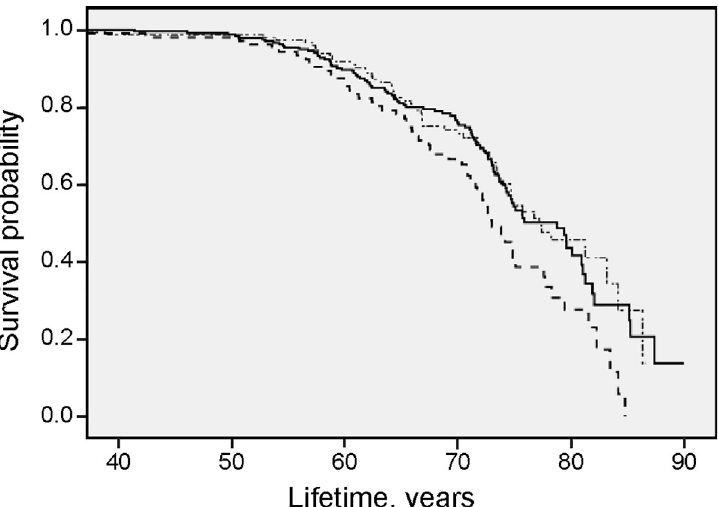
Fig 3. High all-cause mortality with a low serum phosphate level in smokers. Survival probability for all-cause mortality in total patient population. Smokers with S-Phosphate > 1.11 mmol/l ( � ─ � � ─ � � ─ � ), S-Phosphate 0.89–1.11 mmol/l ( ───── ) and S-Phosphate < 0.89 mmol/l (-—-—-—-) illustrated with results from Kaplan-Meier analysis.